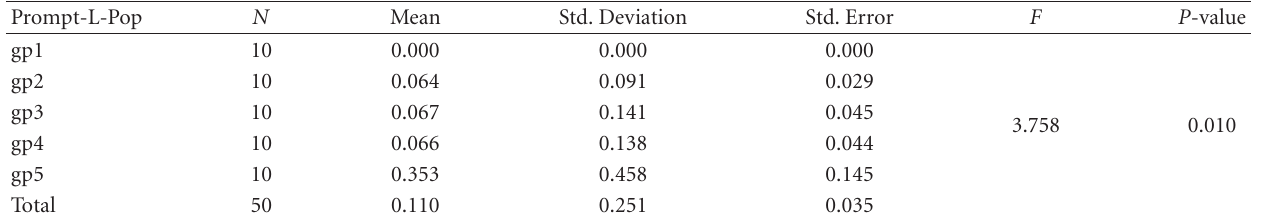
Table 2: One-way ANOVA of the results of dye penetration (in mm.) for Prompt-L-Pop with di ff erent cavity configurations. Prompt-L-Pop